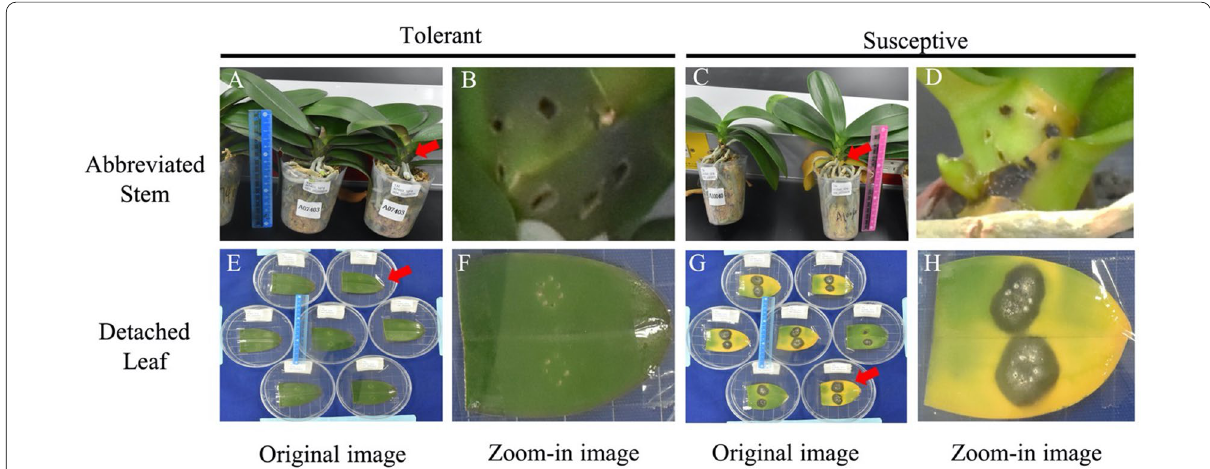
Fig. 3 The phenotypes of tolerant and susceptive cultivars developed on abbreviated stem or detached leaf. The original ( a , c , e , g ) and zoom‑in ( b , d , f , h ) images were shown from abbreviated stem and detached leaf respectively. Varieties TAI_A7403 and TAI_A10040 were shown as tolerant cultivar and susceptive cultivar